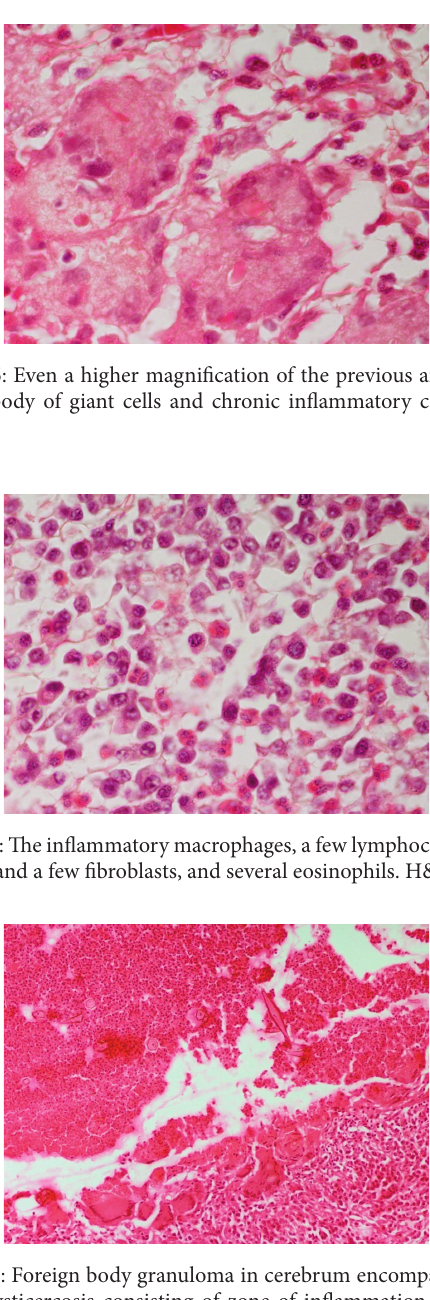
Figure 8: Foreign body granuloma in cerebrum encompassing the neural cysticercosis consisting of zone of inflammation, liquefac- tive/caseous necrosis, and cholesterol clefts besides a few small foci of foreign dystrophic calcification and cholesterol clefts. H&E ×